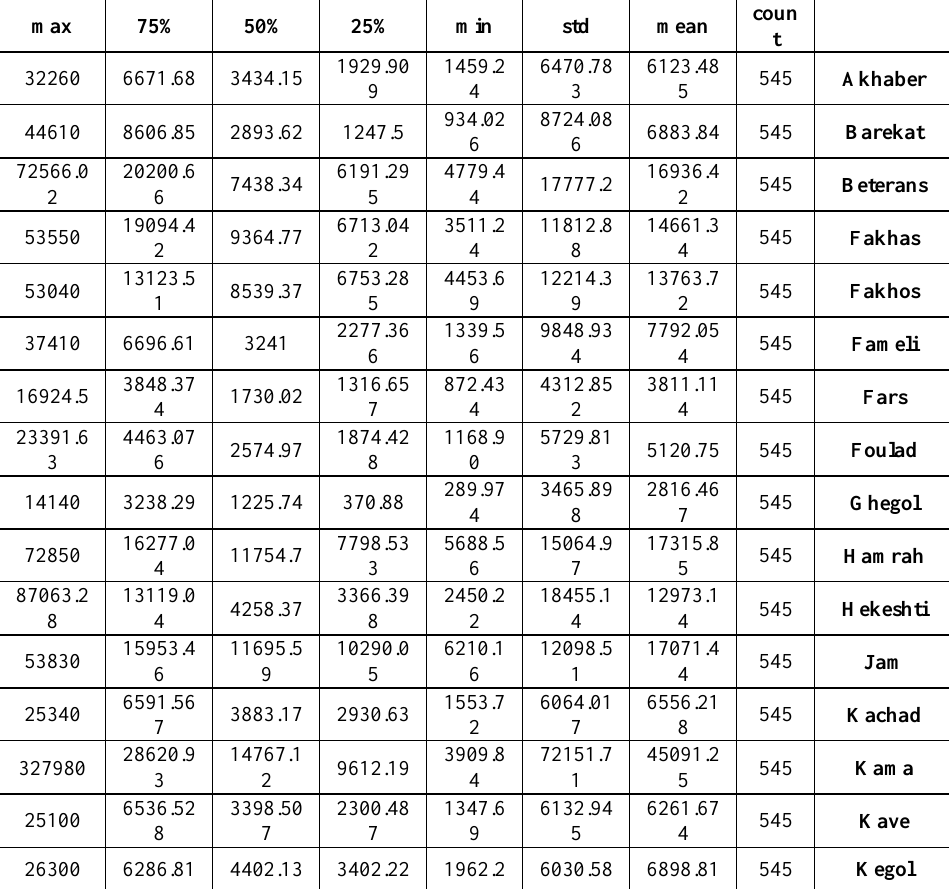
Table 2. Descriptive statistics of